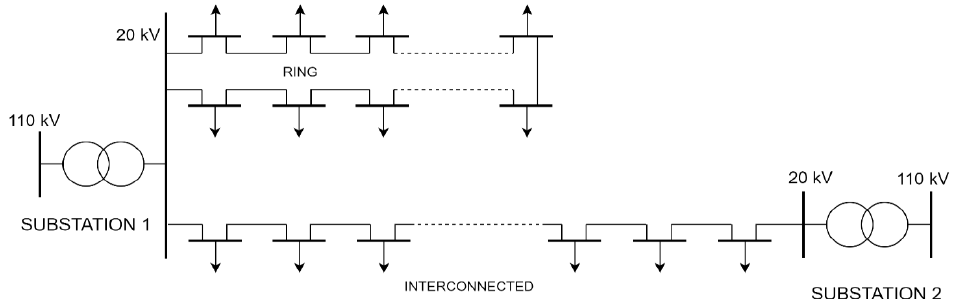
Figure 11. Ring and interconnected topology of a distribution network with meshed operation.